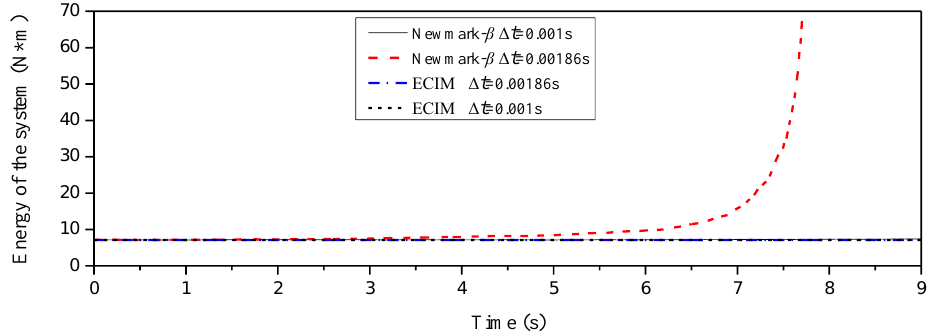
Figure 6. Energy of the system with different time integration methods.